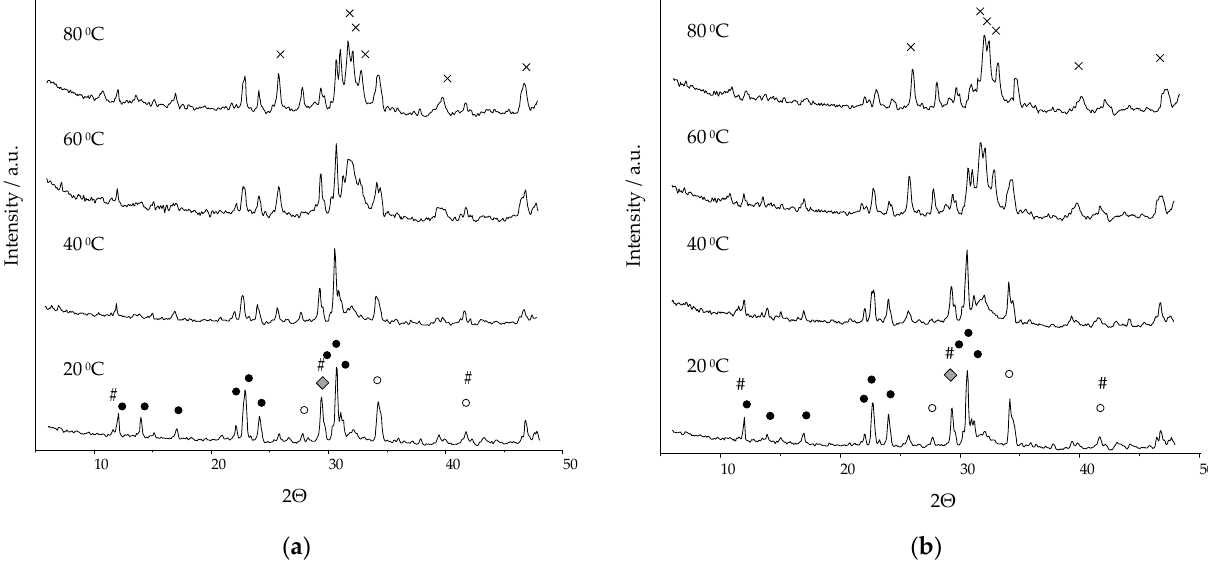
Figure 1. Diffractograms of ceramics consolidated within 24 h based on α -TCP with an average particle size of ( a ) D [3,4] 37.02 µ m ( α -TCP1) or ( b ) D [3,4] 6.12 µ m ( α -TCP2). (cid:108) : α -TCP; Table 1. Surface area and average particle size of α -TCP under different grinding modes.